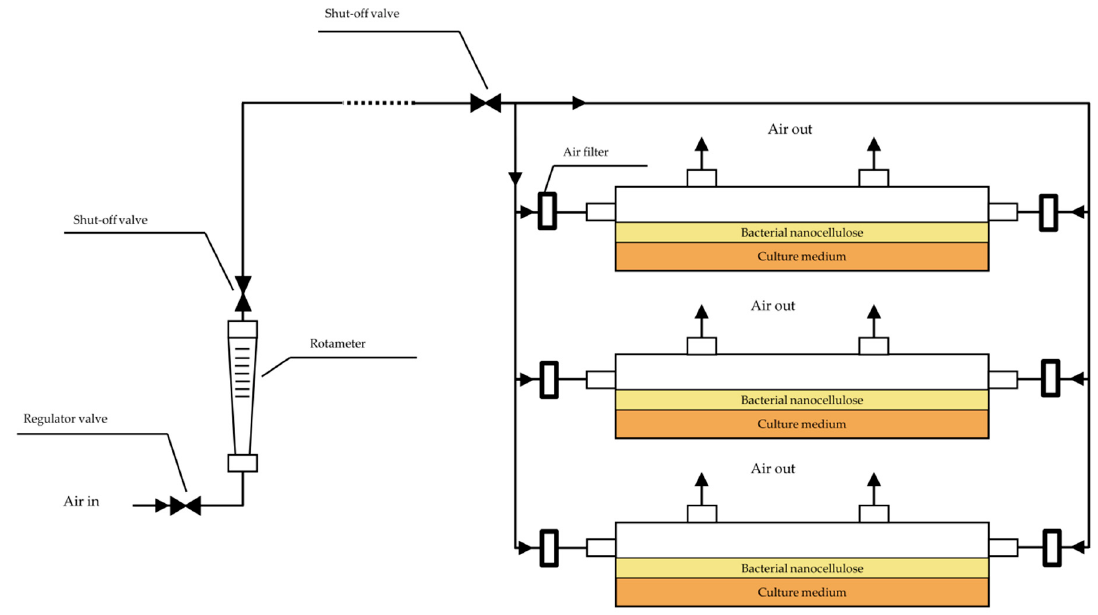
Figure 1. The surface air-flow (SAF) bioreactor. The experimental setup contains 3 glass trays with an area of 2070 or 190 cm 2 , depending on the culture variant. Air is fed by a compressor and passed through the automatic rotameter, which allows measurement and regulation of the air flow ratio. Between rotameter and bioreactors, two safety valves cutting off the air supply are located. Air is purified on sterile filters (PTFE, 0.22 µm) and is introduced into the bioreactors by two spigots placed in the side walls. Air leaves the bioreactors by two outlets placed in the top cover.